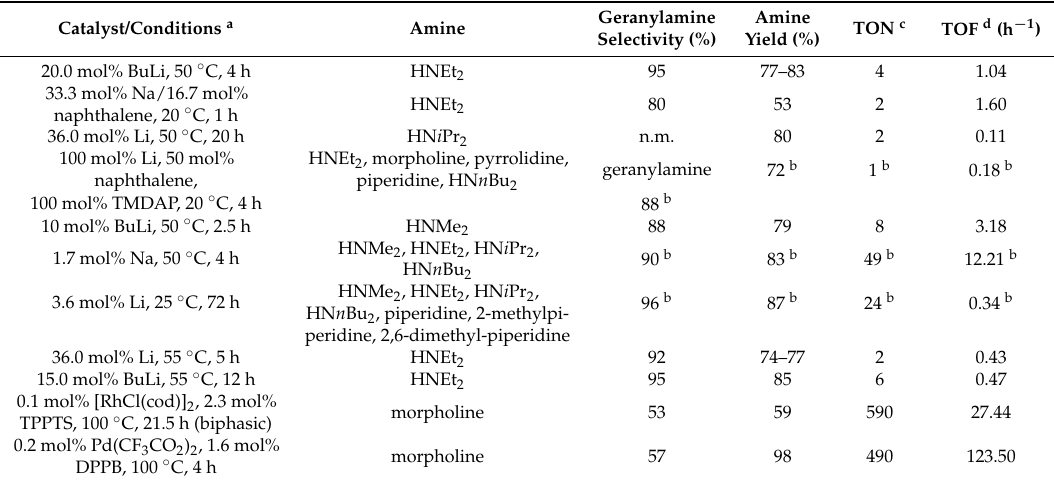
Table 3. Overview of hydroamination investigations *. Adapted from [33].